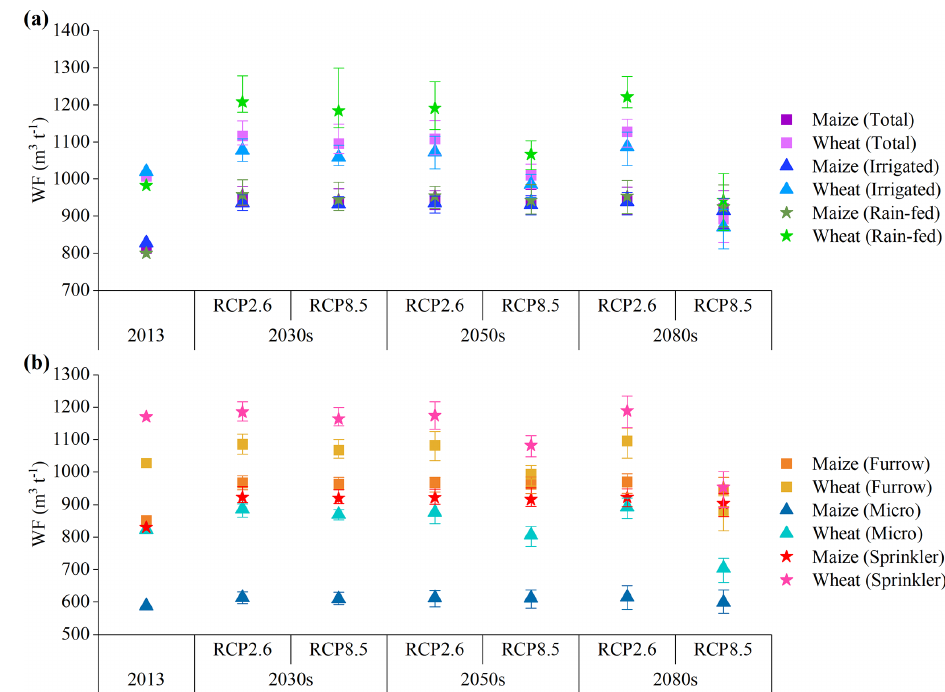
Figure 5. The WFs of maize and wheat in 2013 as well as future year levels under various climate change scenarios in China.